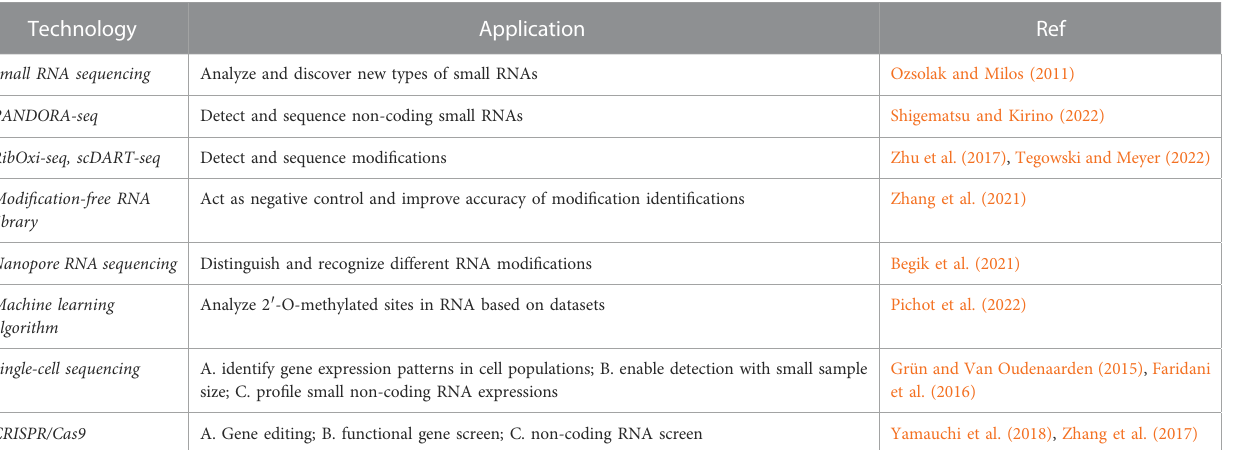
TABLE 1 Cutting-edge technologies applied to study sncRNAs and RNA modi fi